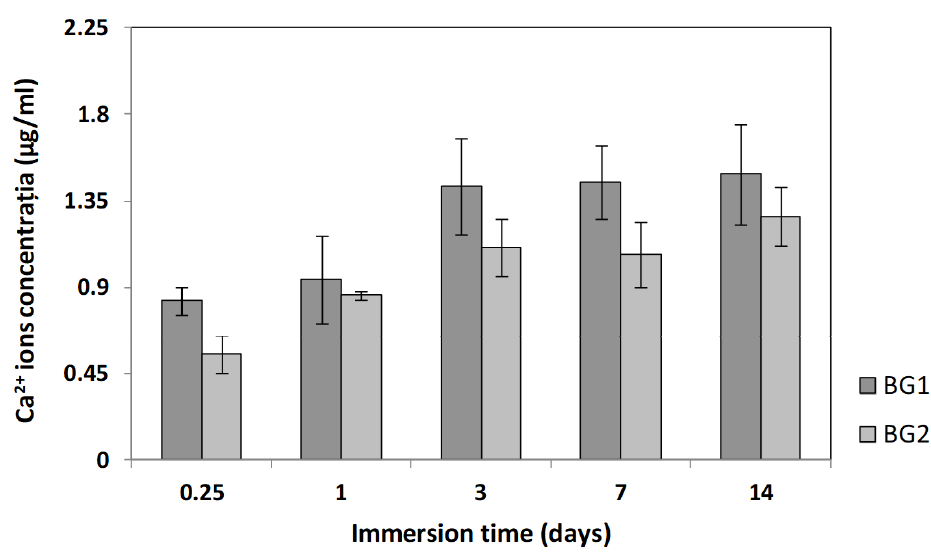
Figure 5. Ca 2+ ions released from BGs immersed in PBS at 37 °C as a function of immersion time (BG1, 100[2B 2 O 3 ·CaF 2 ]; BG2, 0.5V 2 O 5 ·99.5[2B 2 O 3 ·CaF 2 ]). Mean ± SD, n = 3.